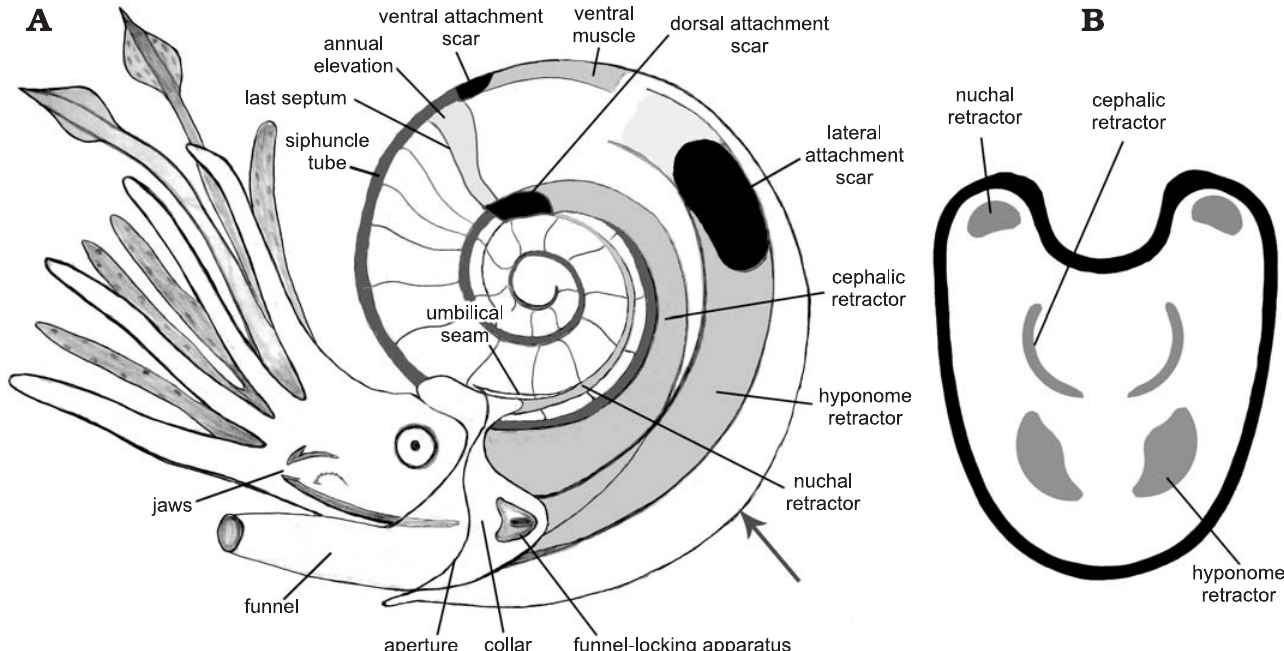
Fig. 13. A . Schematic reconstruction of the ammonite muscular system, lateral view. The mantle and organs in the body chamber are not shown. The size and shape of the arms and tentacles are highly speculative and drawn schematically. Arrow marks position of the schematic cross-section in B. B . Schematic cross-section of ammonite soft body. The cross-section is located in the first third of the body chamber starting from the aperture (arrow in A), only muscles-retractors are